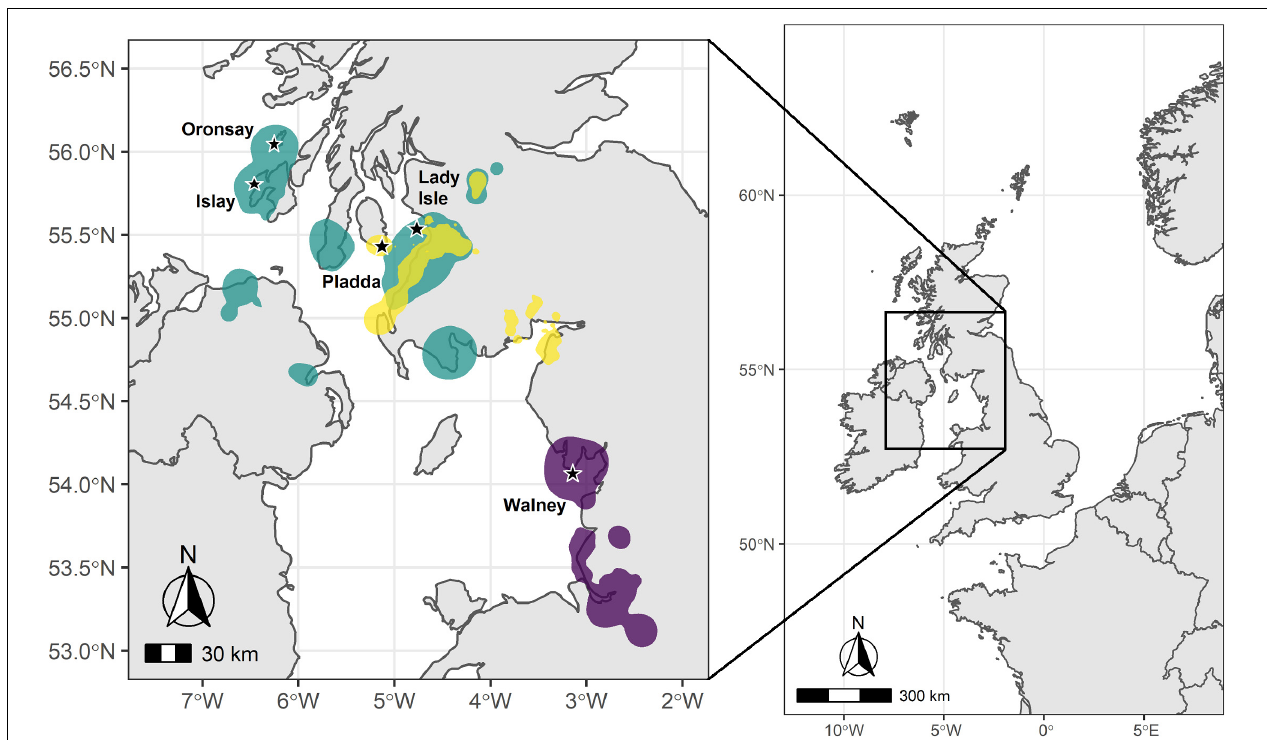
FIGURE 1 | Map of the United Kingdom with the study area in the inset and the herring gull breeding colonies marked with a star. Overlaid are the 95% kernel density estimations (KDEs) of use locations during the non-breeding season (for definition see main text) for individuals from each set of colonies: Green – Southern Hebrides (Islay and Oronsay); Yellow – Firth of Clyde (Pladda and Lady Isle); and Purple – Walney, northwest England. KDEs for each region were weighted by the number of use locations included per